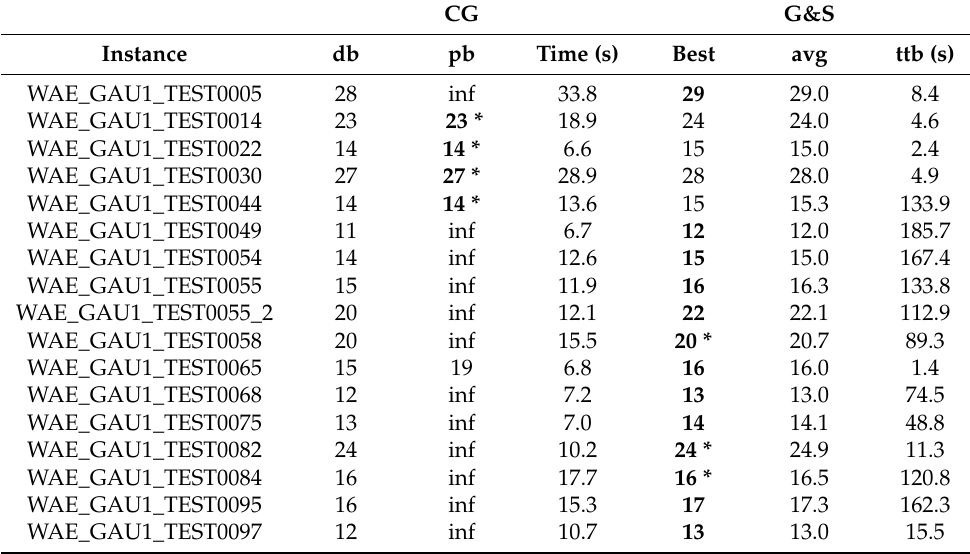
Table 5. Results for the set of instances of class